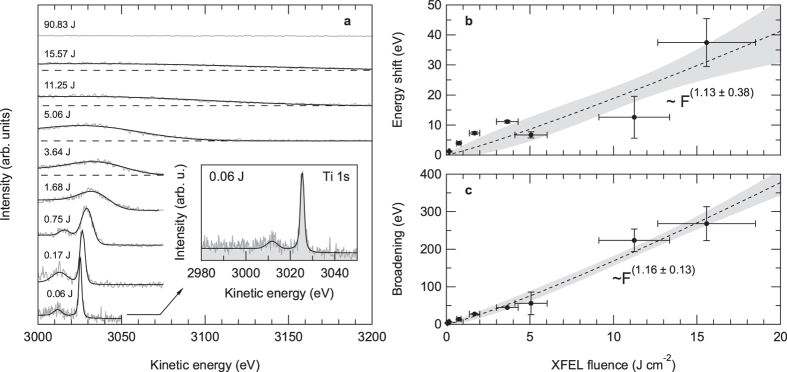
Space-charge effects in XFEL-based micro-HAXPES.(a) Evolution of the Ti 1 s core-level photoemission spectrum of La-doped SrTiO3 as a function of XFEL fluence (hν ≈ 8 keV). All fluences given are pulse energies per cm2. (b) Spectral shift and (c) spectral broadening of the Ti 1 s core-level emission of SrTiO3 as a function of XFEL fluence. The filled symbols are experimental data. The dashed line is a power-law fit to the data, 68.3% confidence bands are indicated by gray filling.